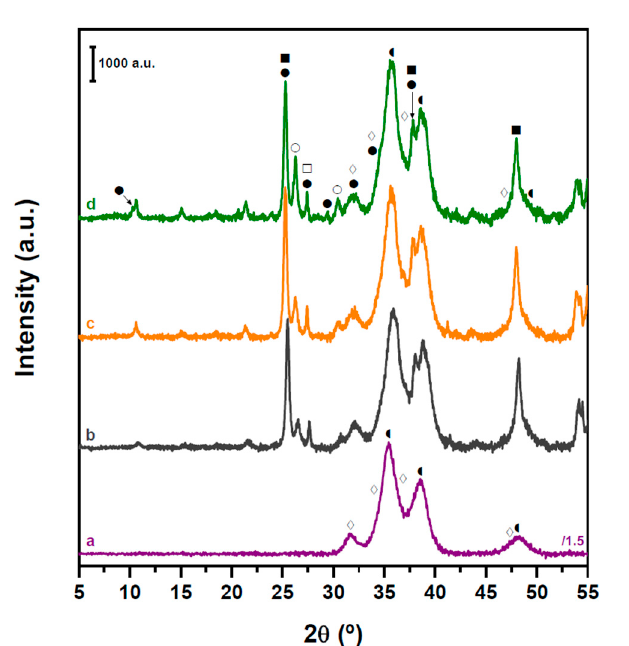
Figure 7. XRD patterns of calcined CZA-xHPW/TiO 2 hybrid catalysts: pristine CZA (a), Figure7. XRDpatternsofcalcinedCZA-xHPW / TiO 2 hybridcatalysts: pristineCZA(a), CZA-1.4HPW / Ti CZA-1.4HPW/Ti (b), CZA-1.7HPW/Ti (c), and CZA-2.7HPW/Ti (d) (anatase ( ■ ), Rutile ( □ ), (b), CZA-1.7HPW / Ti (c), and CZA-2.7HPW / Ti (d) (anatase ( (cid:4) ), Rutile ( (cid:3) ), H 3 PW 12 O 40 · 6H 2 O ( • ),